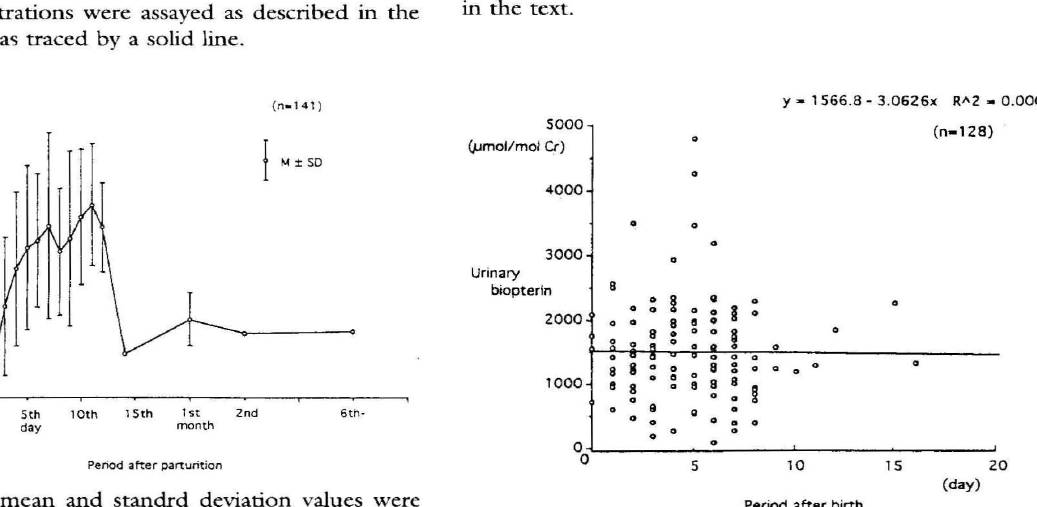
Figure 4. One hundred and twenty eight urinary samples were collected from 22 full term, healthy babies, whose age ranged from 0 to 16 days postpartum. Analysis of uri nary total biopterin was carried out as described in the test. The biopterin concentration in urine showed no sig nificant tendency.